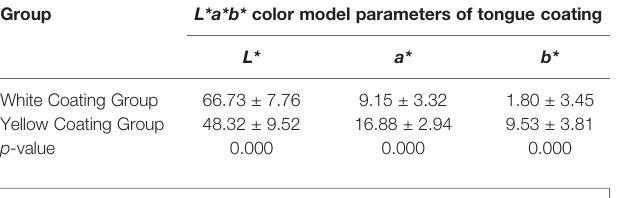
TABLE 2 | Characteristics of the two